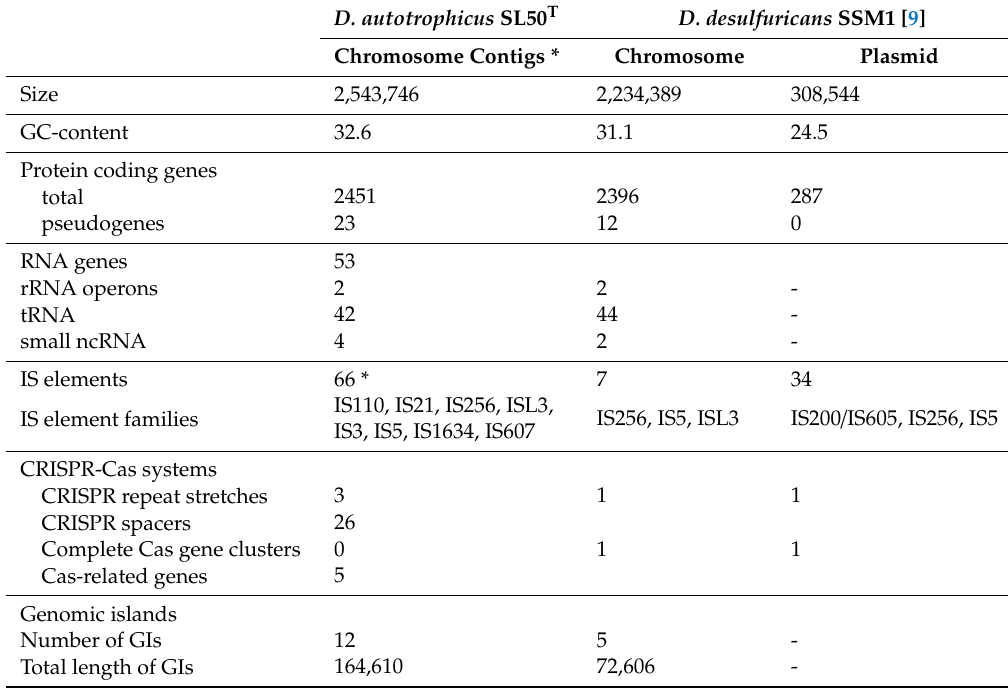
Table 1. Genomic features of D. autotrophicus SL50 T and D. desulfuricans